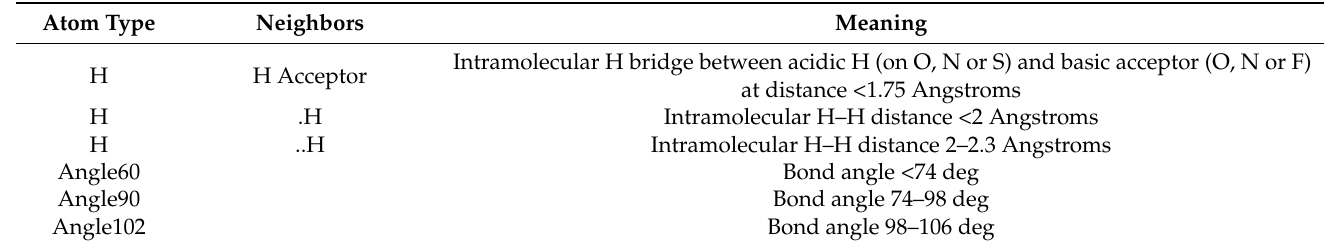
Table 2. Special Groups and their